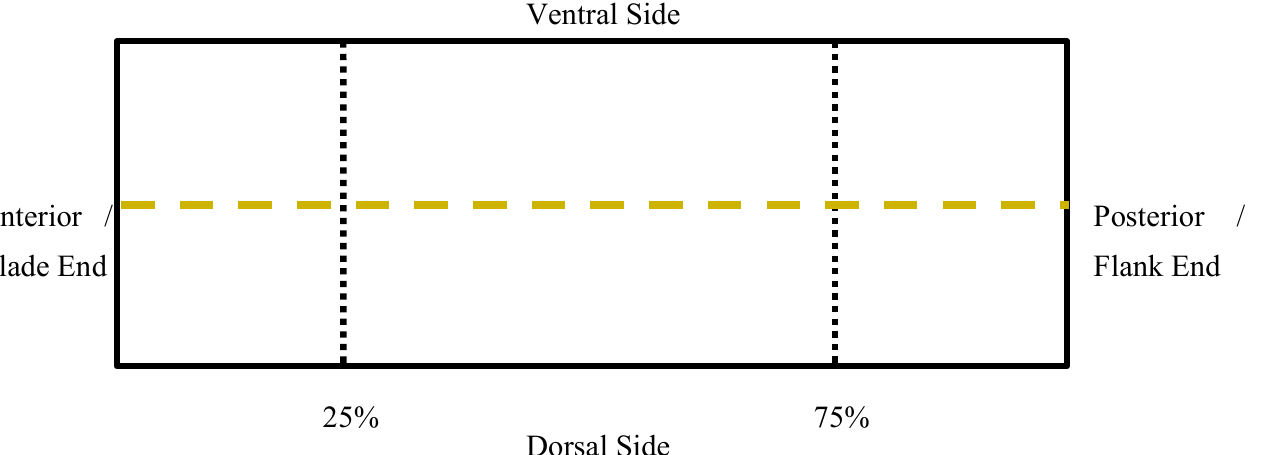
Figure 1. Diagram of belly length measured from anterior (blade) end and posterior (flank) end along the belly midline.